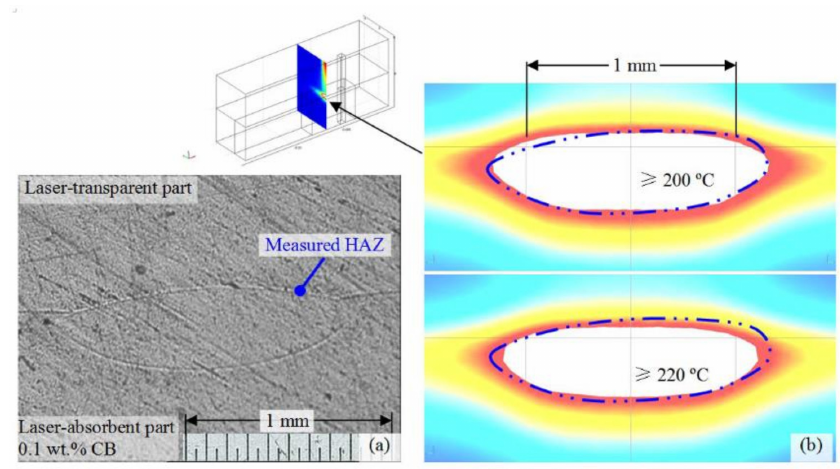
Figure 15. HAZ as observed by a polarized light microscope ( a ) and isotherms obtained from contact model ( b ) for PA6 (0.1 wt.% CB, power 44 W, speed 25 mm/s [203]. Reproduced with permission from Ref. [203]. Copyright (2009), ProQuest Dissertations and